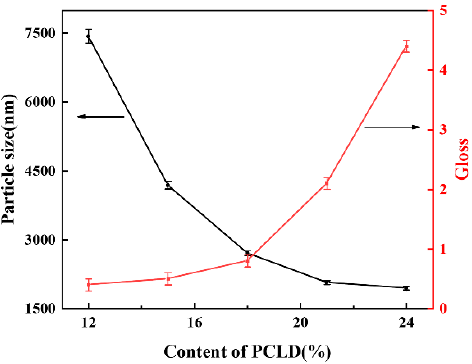
Figure 10. The particle sizes of WPU-P dispersions and gloss of WPU-P films with different PCLD contents.